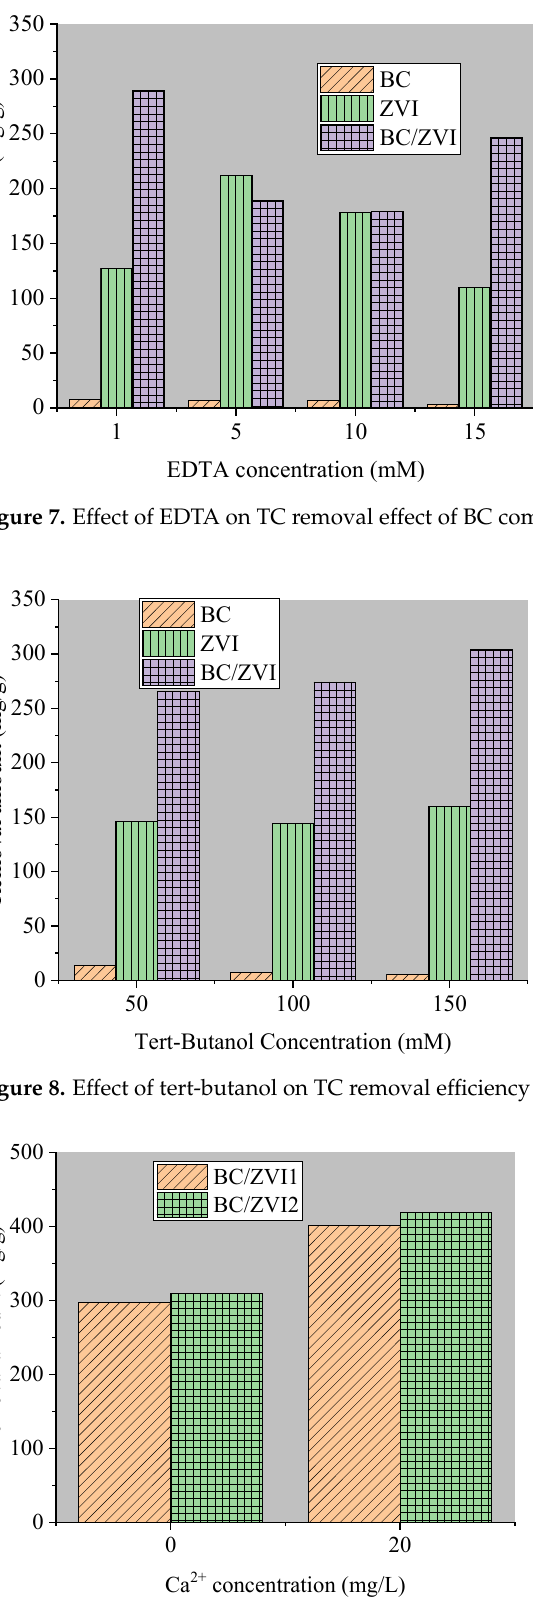
Figure 9. Effect of calcium ion on TC removal efficiency of three materials.